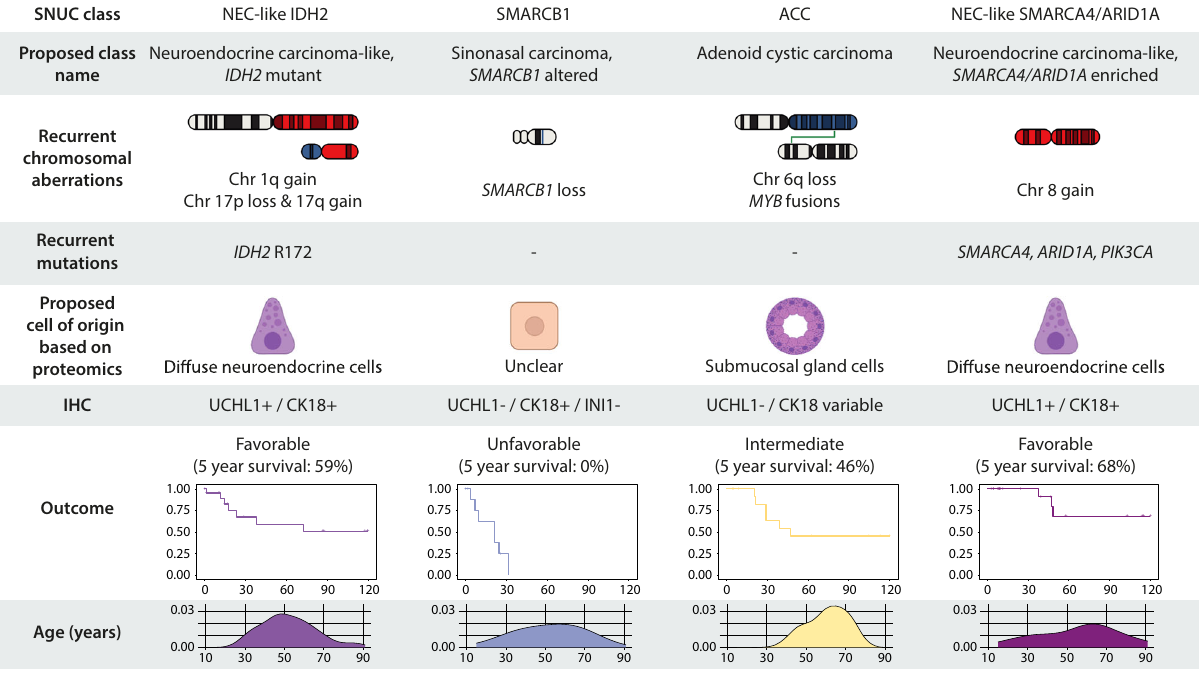
markers. SNUC Sinonasal undifferentiated carcinoma, Chr Chromosome, UCHL1 Ubiquitin carboxy-terminal hydrolase L1, CK18 Cytokeratin